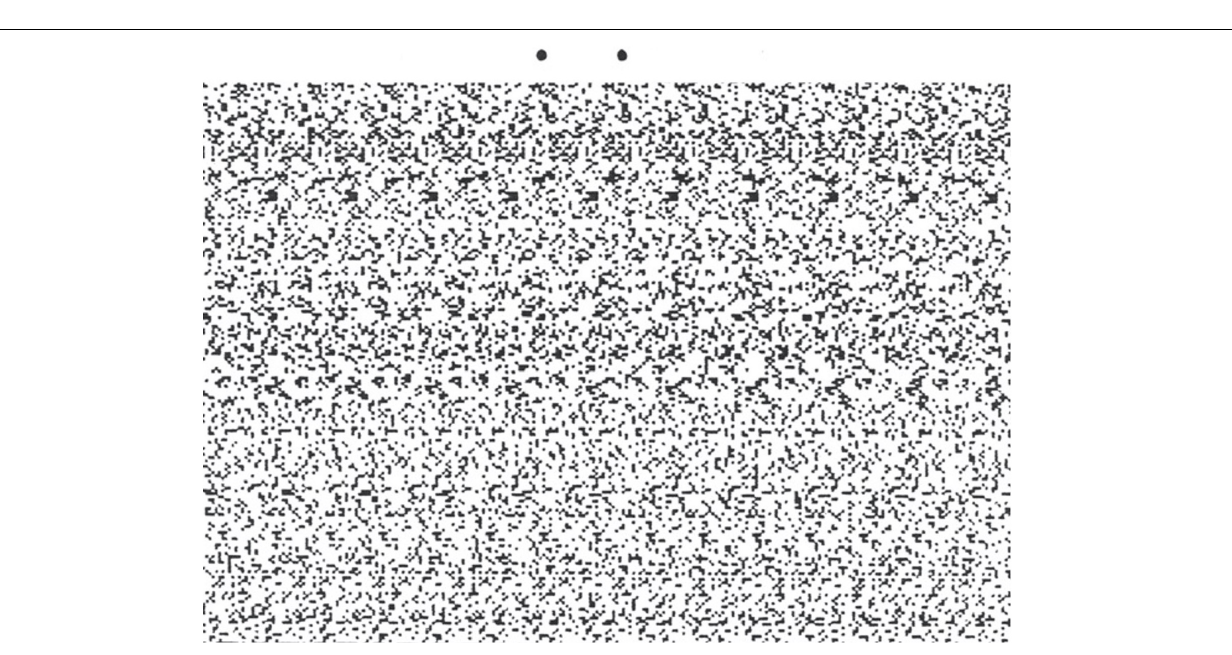
color mixtures that match a simple color or other color